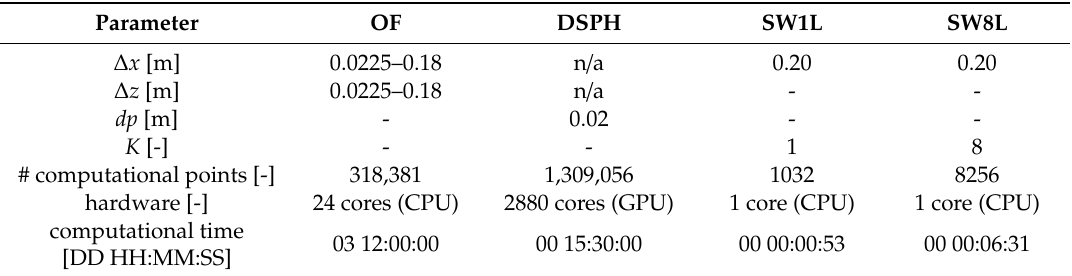
Table 6. Grid resolution, number of cells and approximate computational times of each applied numerical